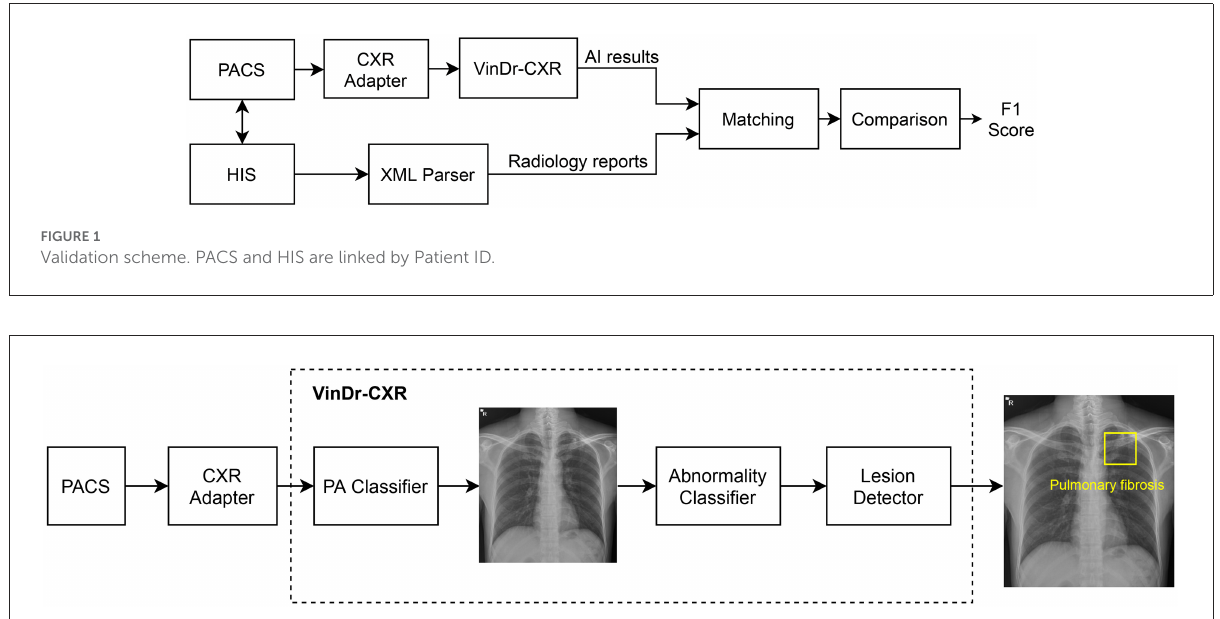
FIGURE2 VinDr-CXR pipeline. The system includes three concatenated AI models that are integrated to the PACS via a CXR adapter. The output of the system is the probability of the CXR being abnormal and the locations of the lesions, if any.